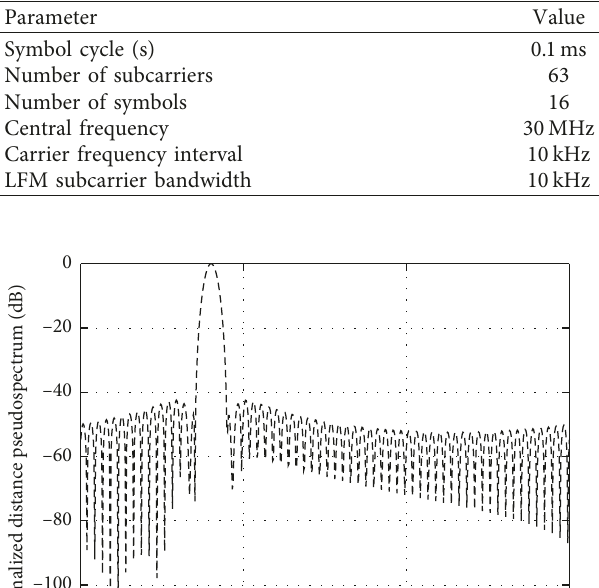
Table 1: Main simulation parameters of unified measurement and control communication system.